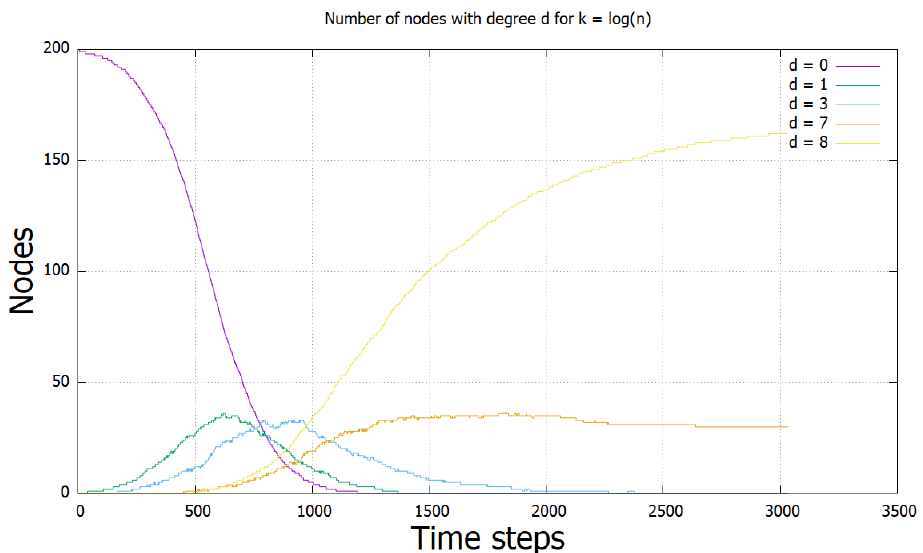
Figure 4. The results for k = log n . Here, we see the beginning of a leftwards shift of the lines, and an upwards shift in d = k